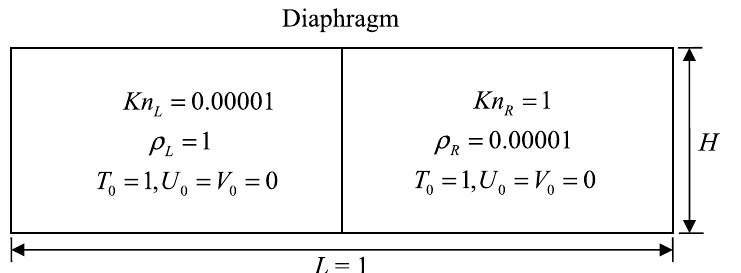
Fig. 20 Unsteady gas expansion in a channel